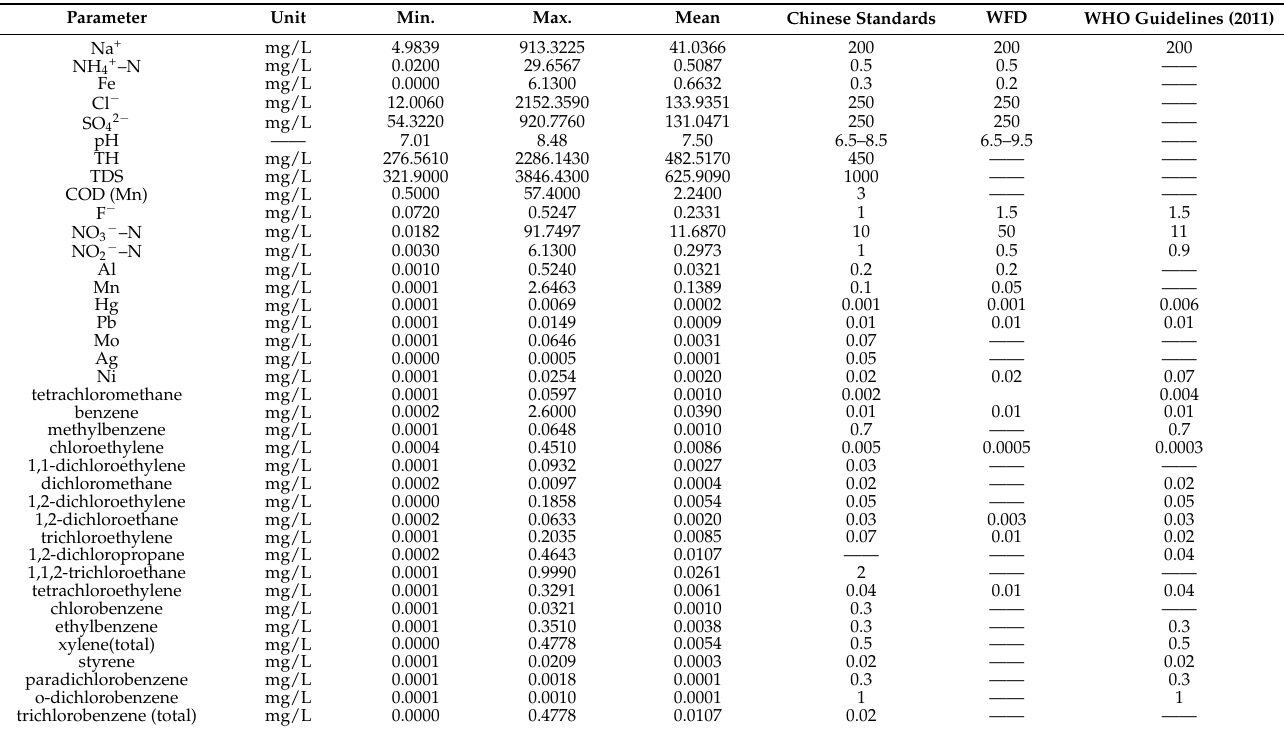
Table 1. Summary of sample well index data and index limits.